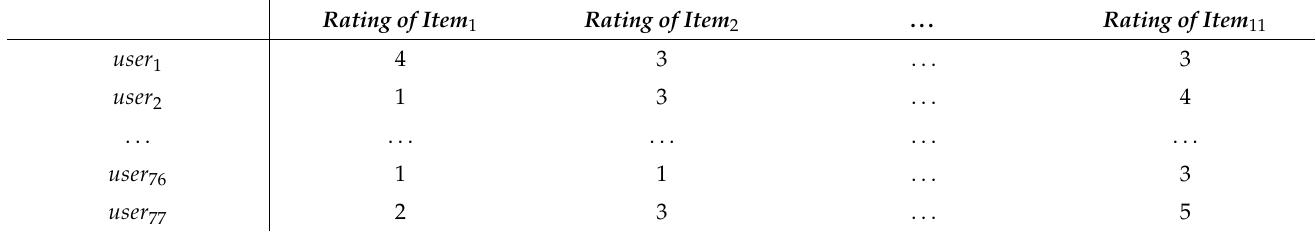
Table 3. Actual user rating